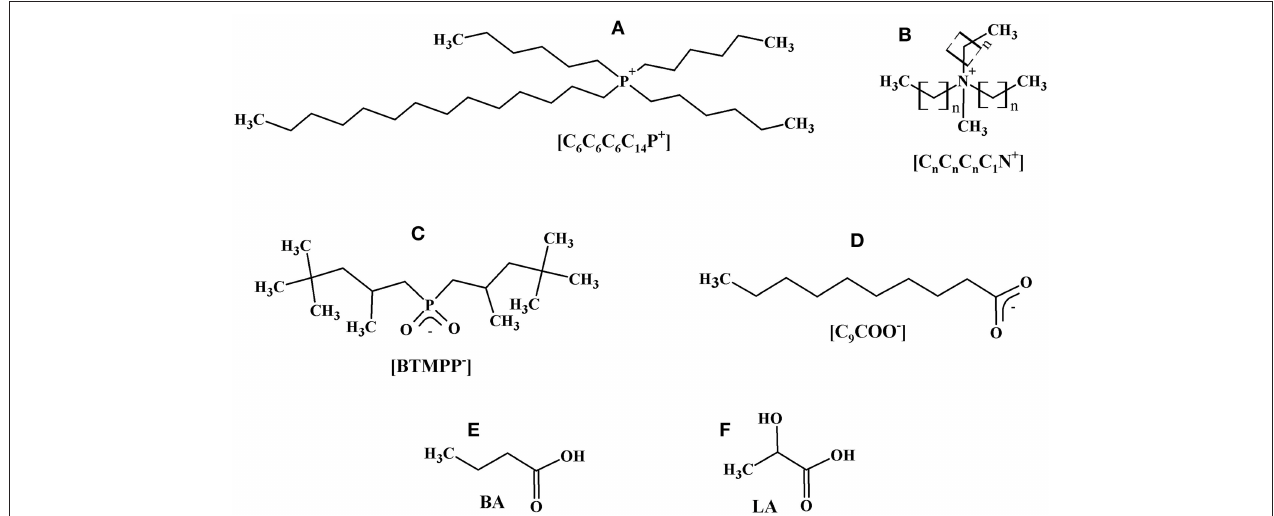
FIGURE 2 | Structural formulas of tetradecyltrihexylphosphonium (A) trialkylmethylammonium (B) cations, bis-(2,4,4-trimethylpentyl)phosphinate (C), and decanoate (D) anions, butyric (E), and lactic (F) acids. In panel (B) n = 6, 8, or 10.